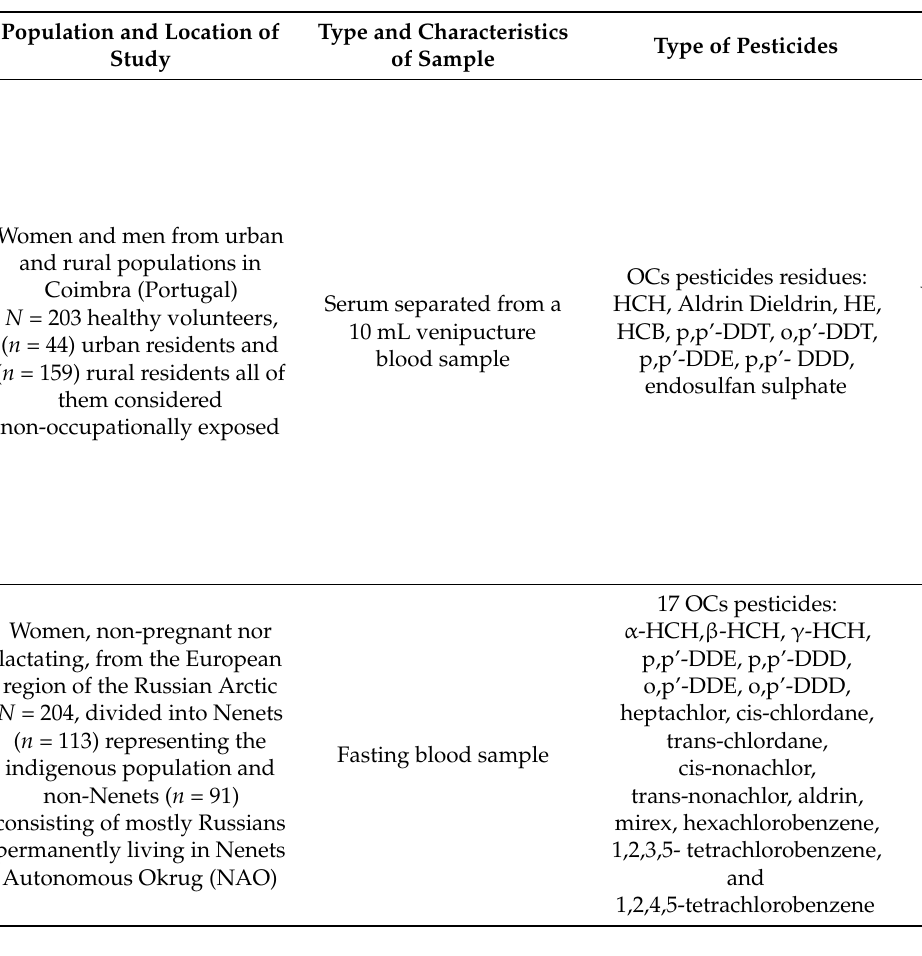
Table 5. Main pesticides detected in biological samples from